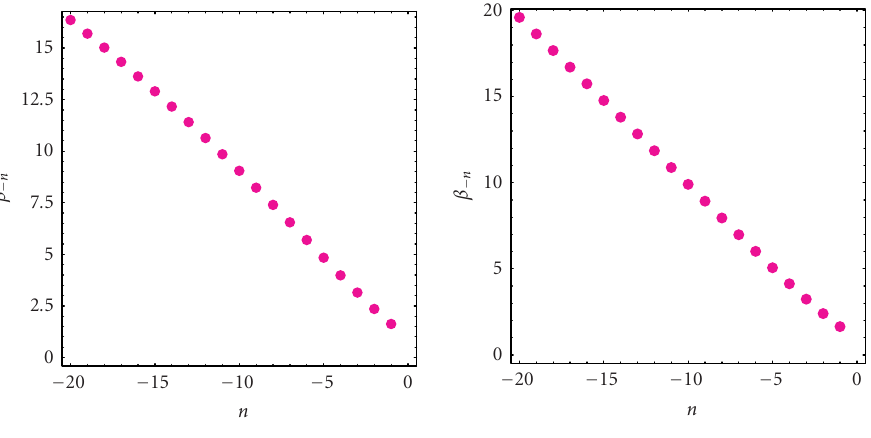
Figure 3.10. The curve of β − n ( n | q ), q = 99 / 100,999 / 1000.